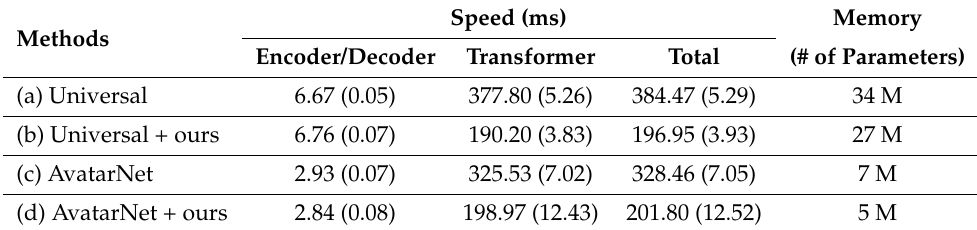
Table 1. Quantitative comparison of existing style transfer methods and the result of the proposed pruning method: the speed (ms) is the average (standard deviation) measured using 1000 test images not used during the network